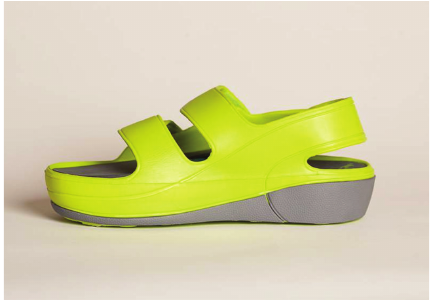
Figure 1: The MMC sandal which houses the compression device within the sole.